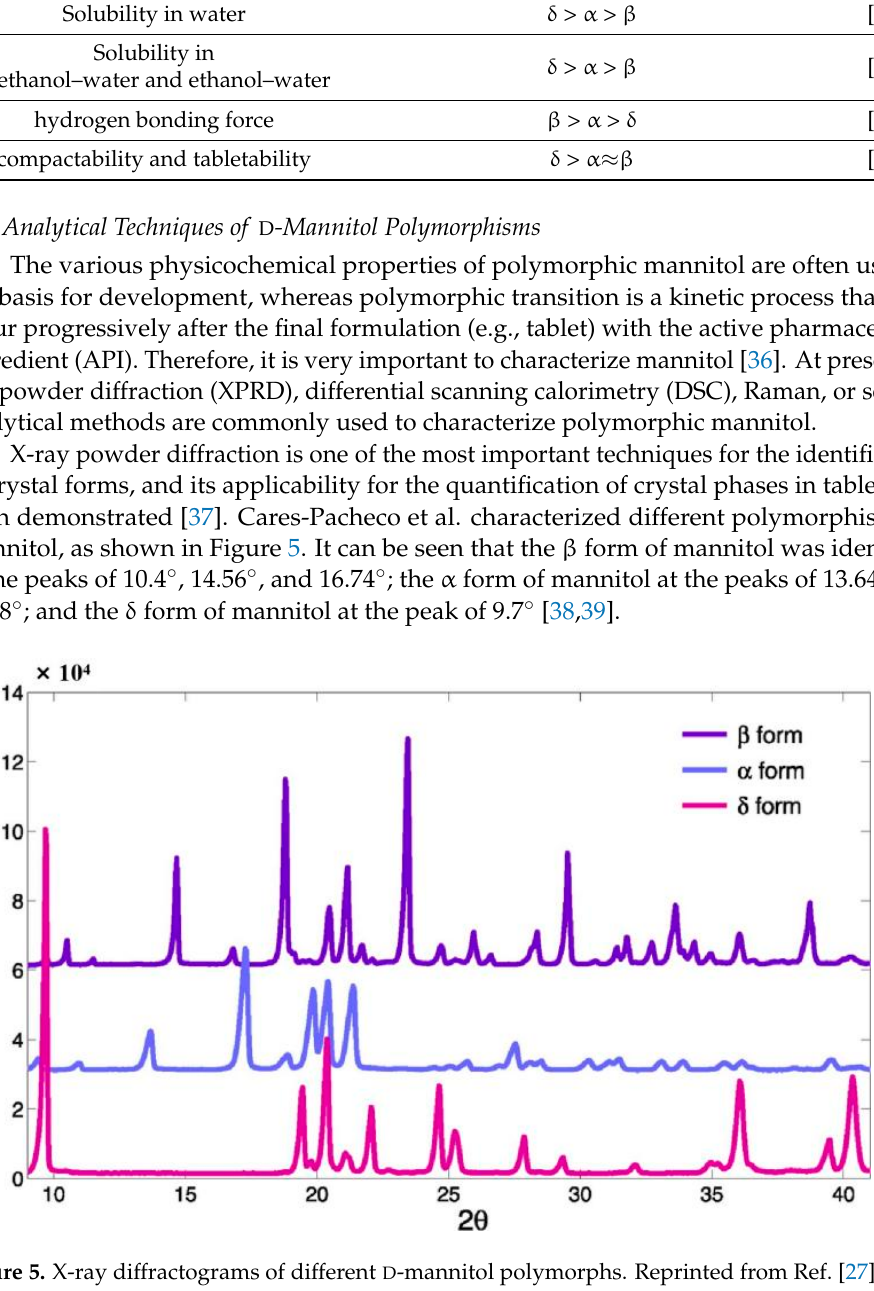
Figure 5. X-ray diffractograms of different D -mannitol polymorphs. Reprinted from Ref. [27] Copy- right 2014, with permission from Elsevier.